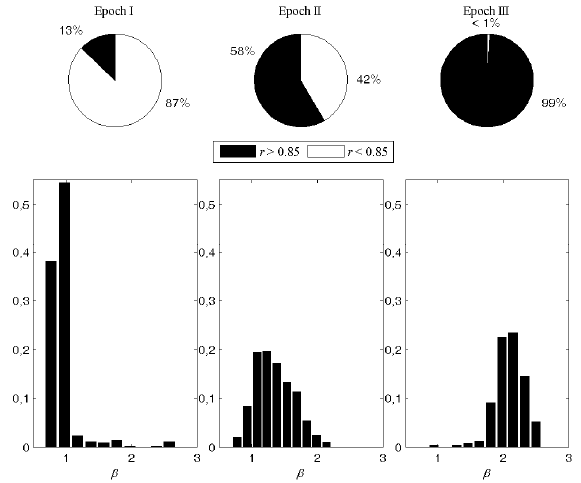
Fig. 7. The lower part shows distribution of the spectral scaling exponent, β , estimated for the population of the short duration win- dows which presented fitting to power law better than 85%, over the three epochs of the EM recording under analysis. The upper part shows the percentage of the correlation coefficient, r , lying above the threshold of 0.85 for each one of the three